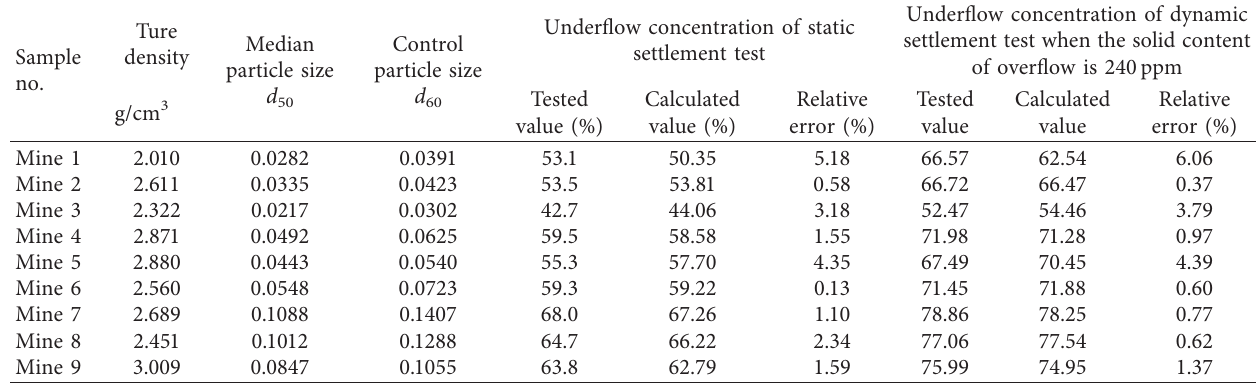
Table 6: Comparison of calculation results and test